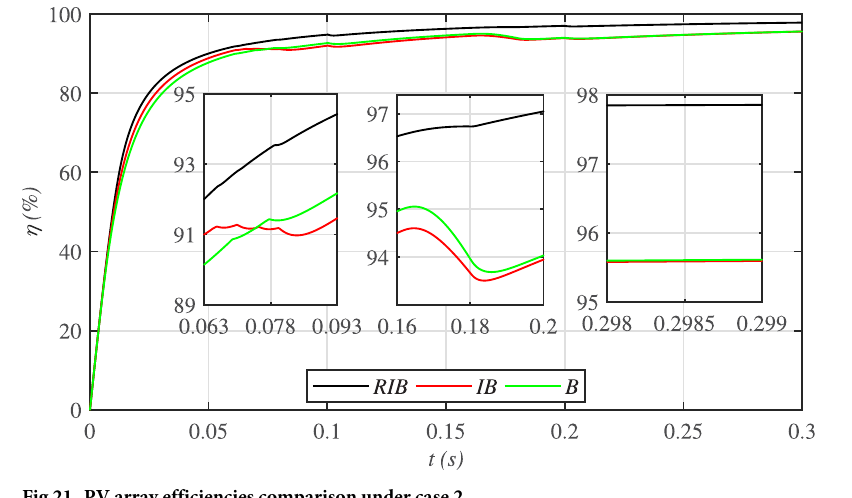
Fig 21. PV array efficiencies comparison under case